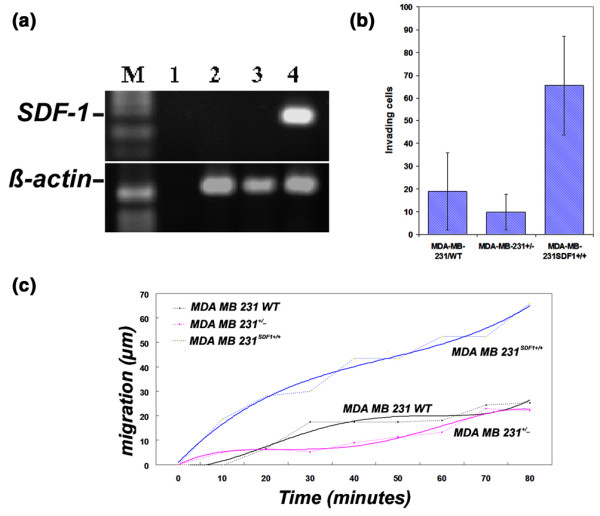
Manipulation of expression of SDF-1 in breast cancer cells. (a) The efficiency of stromal cell-derived factor (SDF)-1 transfected in MDA-MB-231 cells was confirmed by PCR. M: marker; 1: negative control; 2: MDA-MB-231 wild-type; 3: empty vector control MDA-MB-231+/-; 4: SDF-1-transfected MDA-MB-231SDF1+/+. (b) Invasiveness of transfected cells. *P < 0.01 versus control and wild-type. (c) Cellular migration.